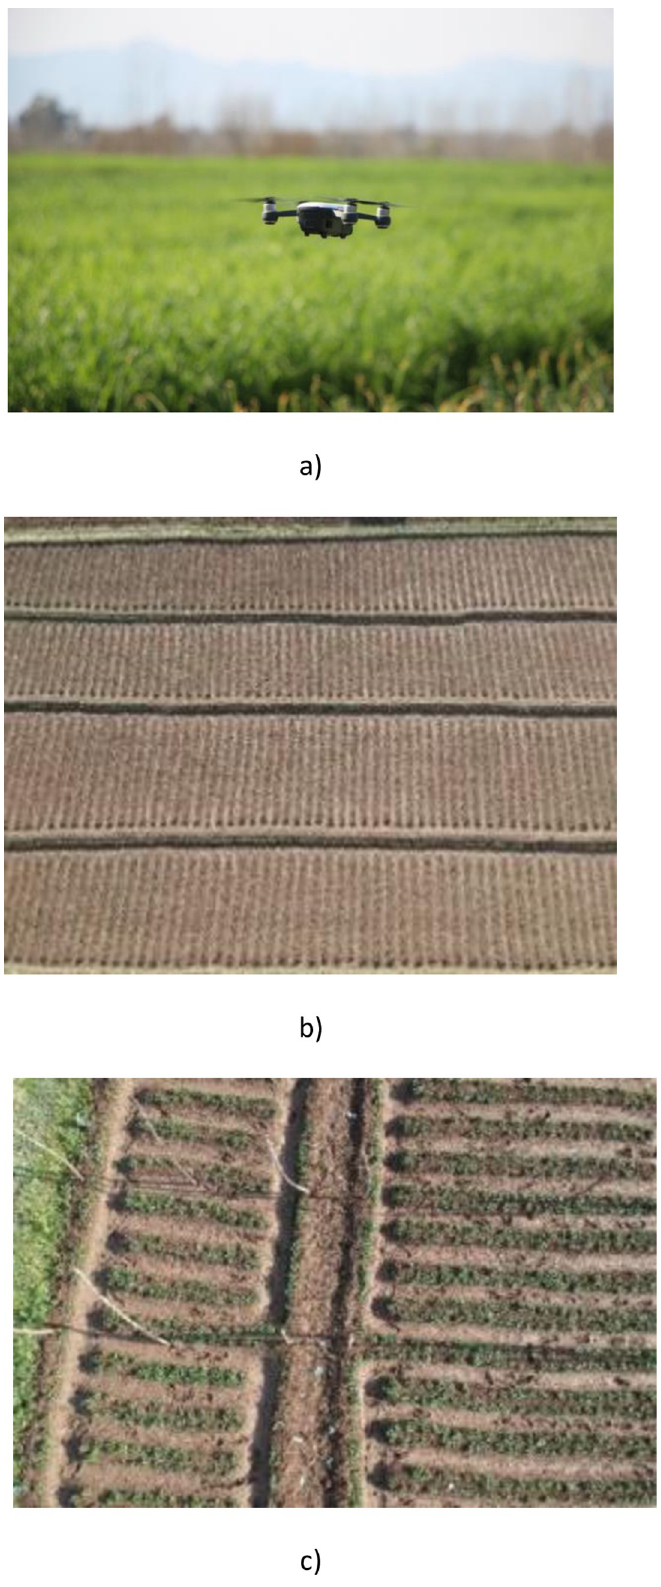
Fig 4. Overview of UAV and experimental site. a) DJI Spark (Multi-Rotor). b) Pea Field. c) Strawberry Field. https://doi.org/10.1371/journal.pone.0251008.g004 PLOS ONE | https://doi.org/10.1371/journal.pone.0251008 May 10,